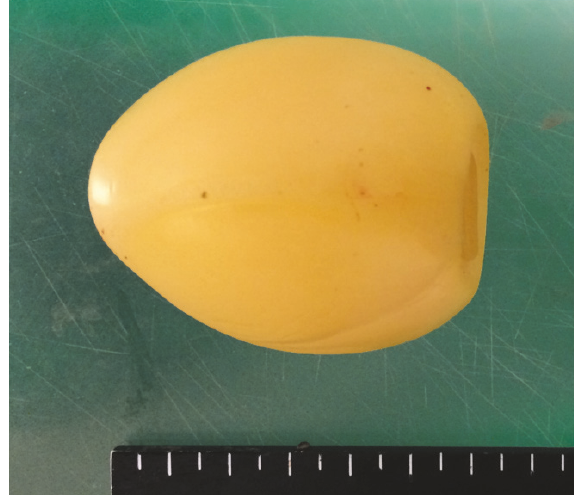
Figure 4: The abnormally dilated small bowel is exteriorized. A luminal obstructing foreign body was palpable.